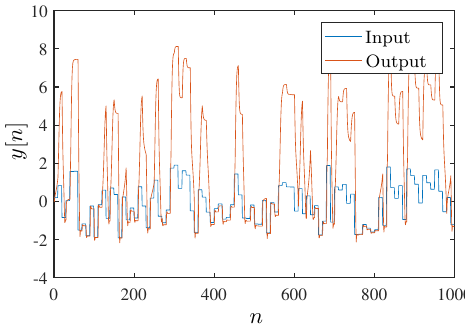
Figure 18. Plant data used.